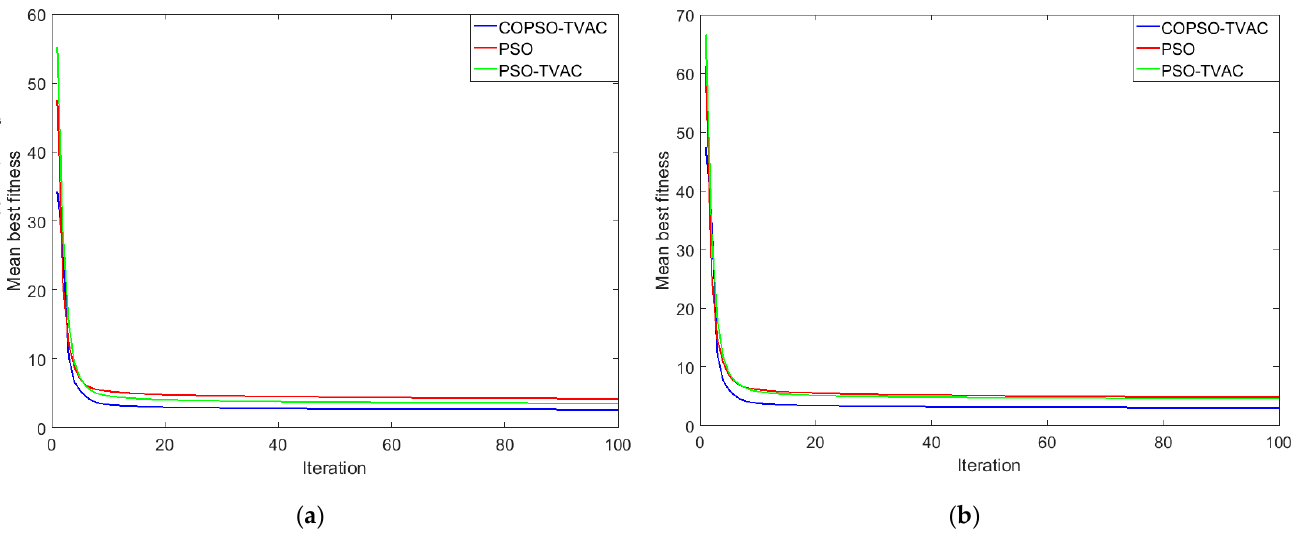
Figure 9. The convergence properties of the proposed metaheuristic algorithms in the scenario with 3 NLOS BSs: ( a ) the suburban environment; ( b ) the urban environment.